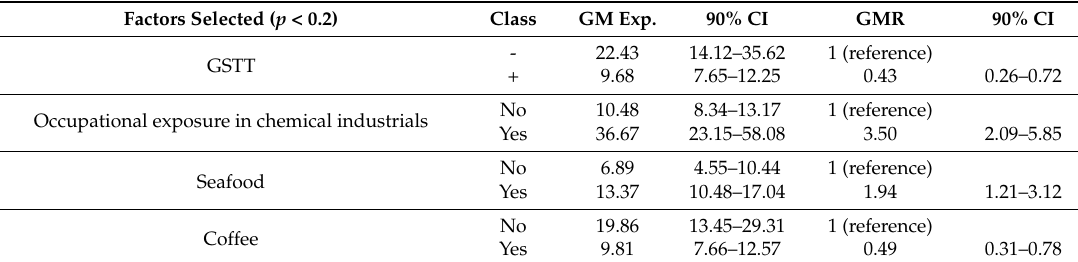
Table 7. Gela sample. Factors associated with u(iAs+MMA+DMA) concentration by stepwise multivariate